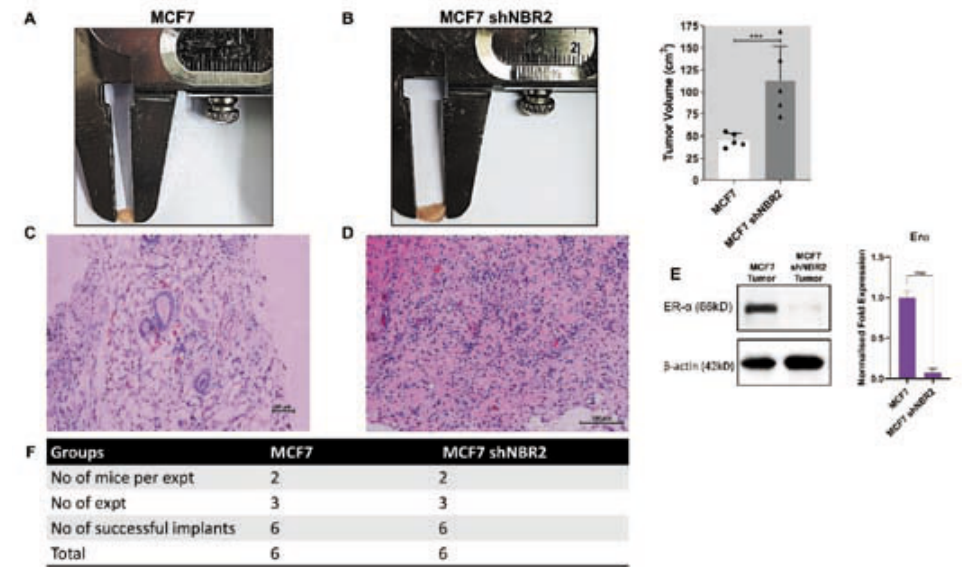
Figure. 3. a & B represent the difference in tumour volume generated from wildtype and NBR2 knockdown MCF7 cells, respectively. c & D represent H & E images of wildtype and NBR2 knockdown tumours, respectively. E shows ER-α expression in NBR2 knockdown tumours analysed via immunoblotting. F shows the no of mice used for in vivo